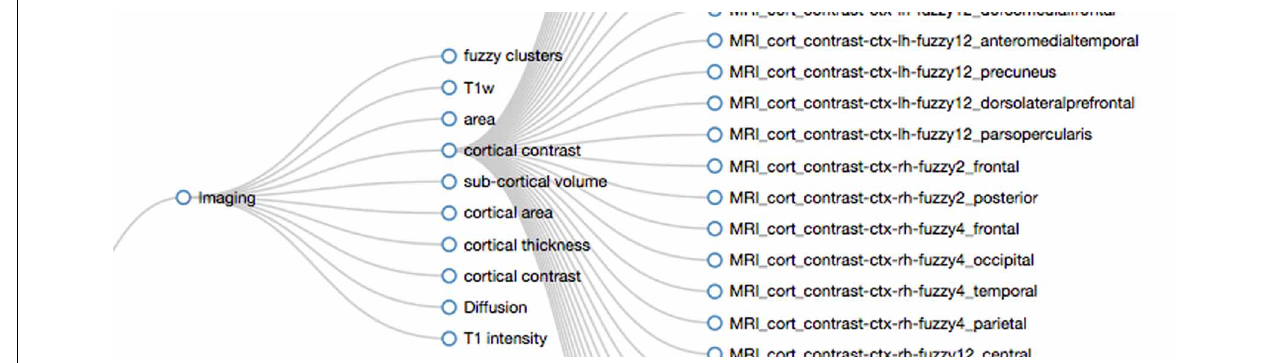
H_contrast|H_volume|H_intensity|Diffusion|H_Fuzzy)/”. The entry “cortical contrast” (H_contrast) is implemented by the pattern “/(ˆMRI_cort_contrast)/”. In PING this maps to all MRI related cortical contrast measures in the data dictionary (subset displayed on the